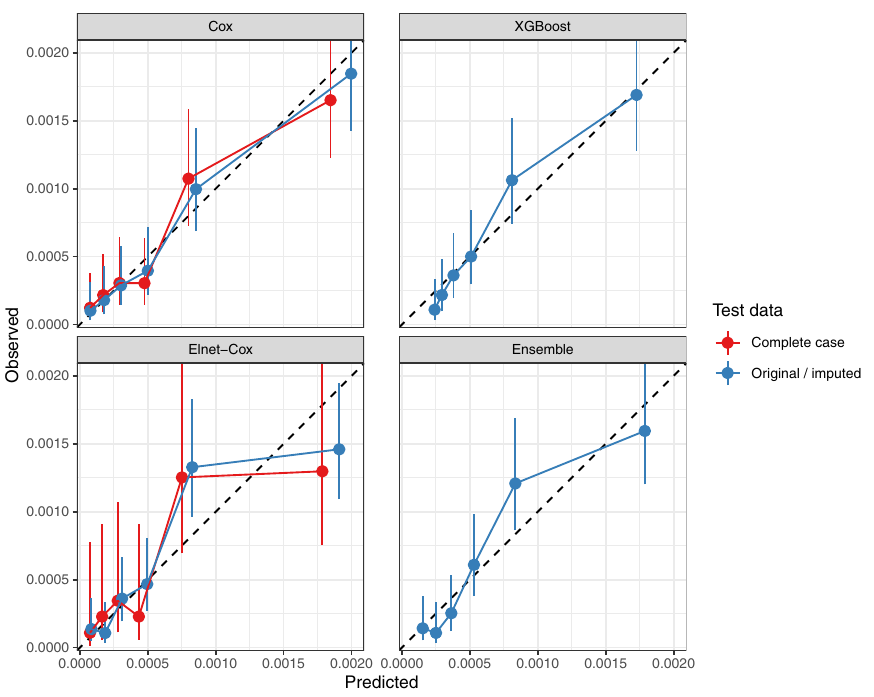
Fig. 4 Calibration plot of the stroke models Calibration plot showning observed vs. predicted risk of the model. Observations were divided into groups of roughly same size based on the risk score (linear predictor) computed from the model. The observed risk and its 95% con fi dence intervals were computed from the Poisson